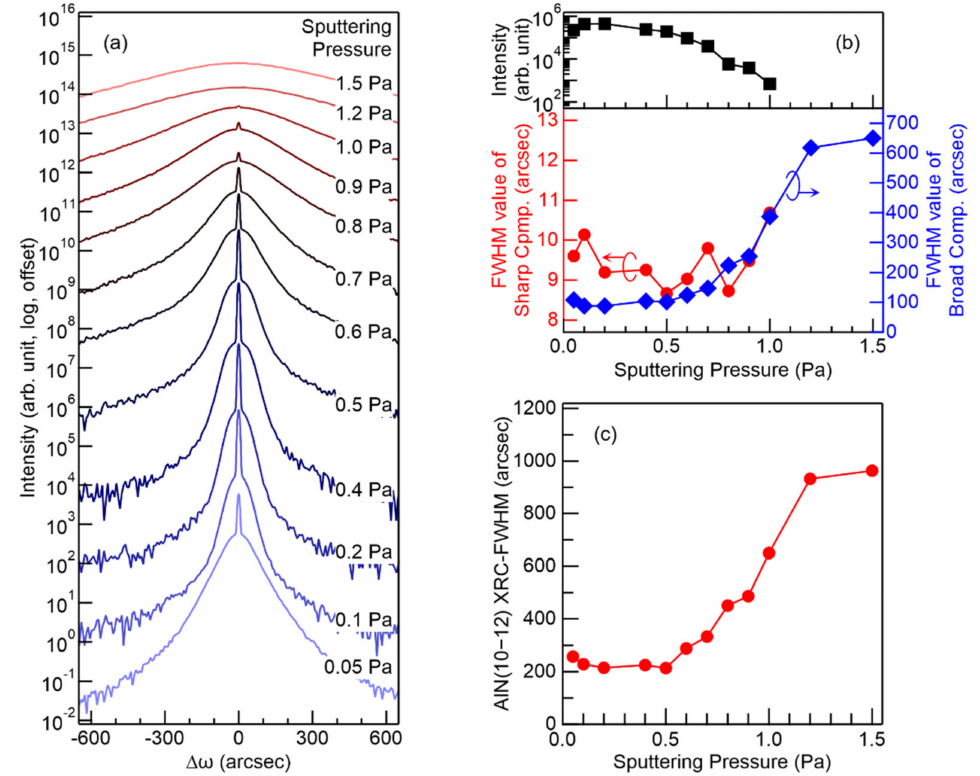
Figure 7. ( a ) Sputtering pressure dependent high-resolution XRC profiles of FFA Sp-AlN consider- ing the AlN(0002) diffraction. ( b ) Effect of sputtering pressure on the peak intensity of the sharp component and XRC-FWHM values of the sharp component and broad component of the AlN(0002) diffraction. ( c ) Relationship between AlN(10 − 12) XRC-FWHM values of FFA Sp-AlN and sputter- ing